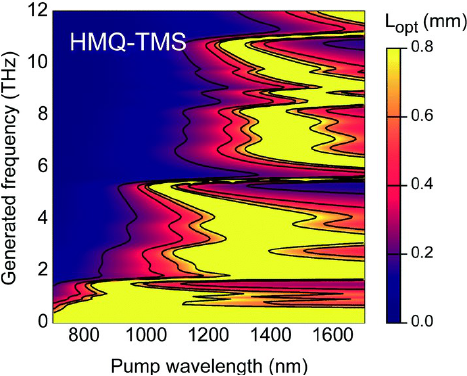
Figure 17. Optimum crystal length l opt ( ν , λ ) for the generation of THz waves as a function of the pump optical wavelength, and the frequency of the generated THz wave for HMQ-TMS for both pump and THz waves polarized along the polar axis. Used with permission from the Royal Society of Chemistry, from [195]; permission conveyed through Copyright Clearance Center, Inc. Table 21. Main optical-THz characteristics of HMQ-TMS.